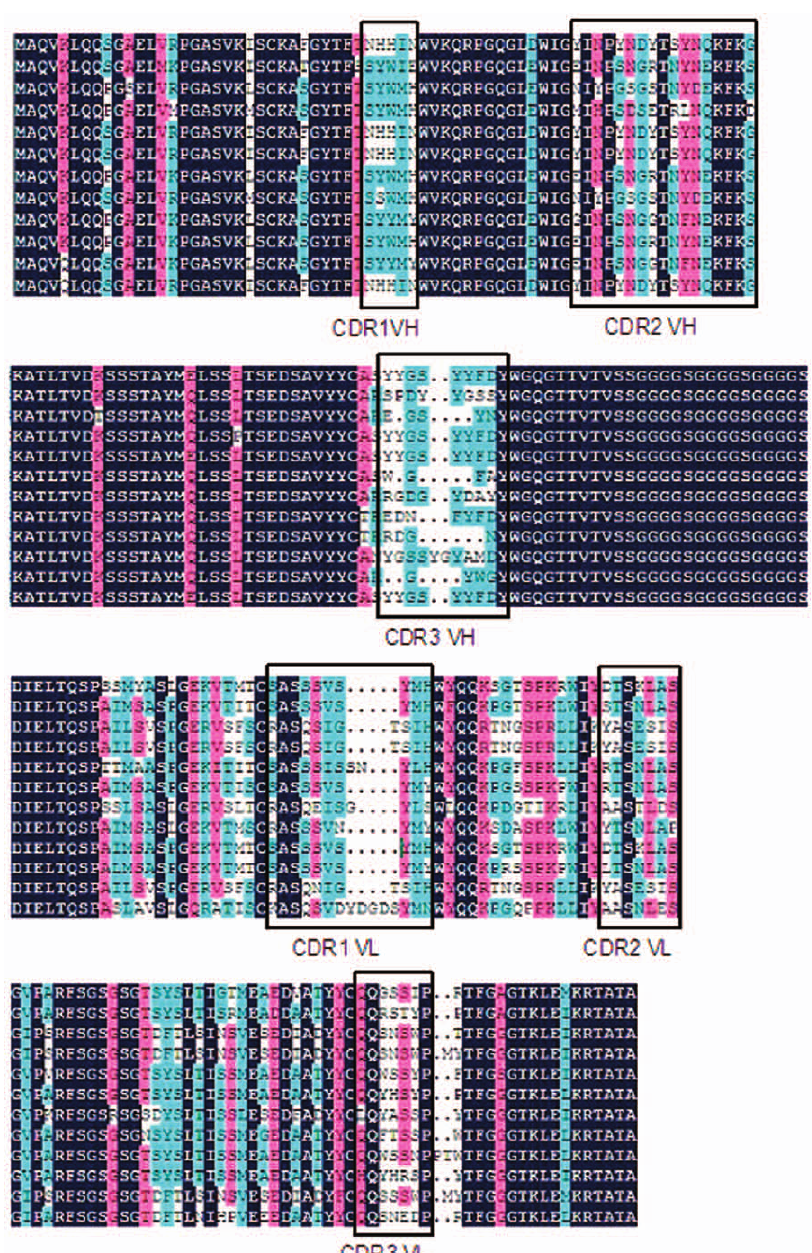
Figure 2. The deduced amino acid sequences of the scFvs and complementary determining regions (CDRs). The deleted residues are represented by a dash (-). FRs and CDRs are determined according to the Kabat